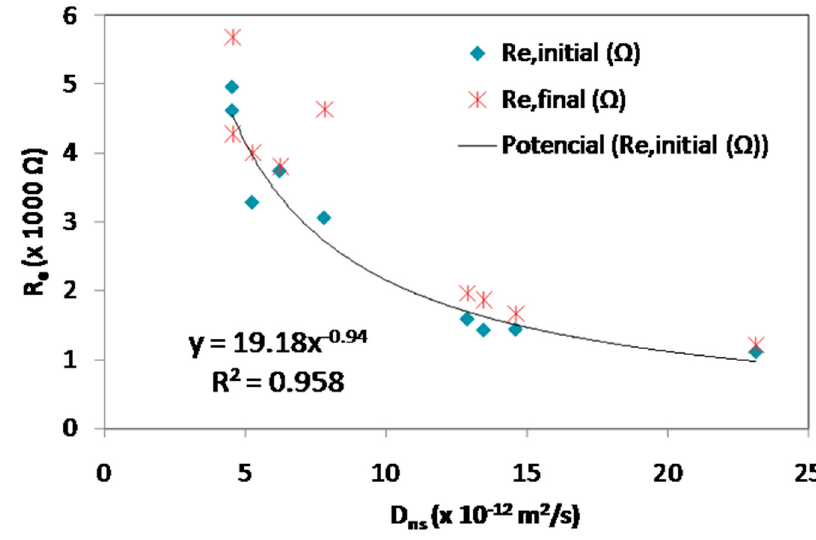
Figure 5. Initial and final resistance vs. non-steady state di ff usion coe ffi